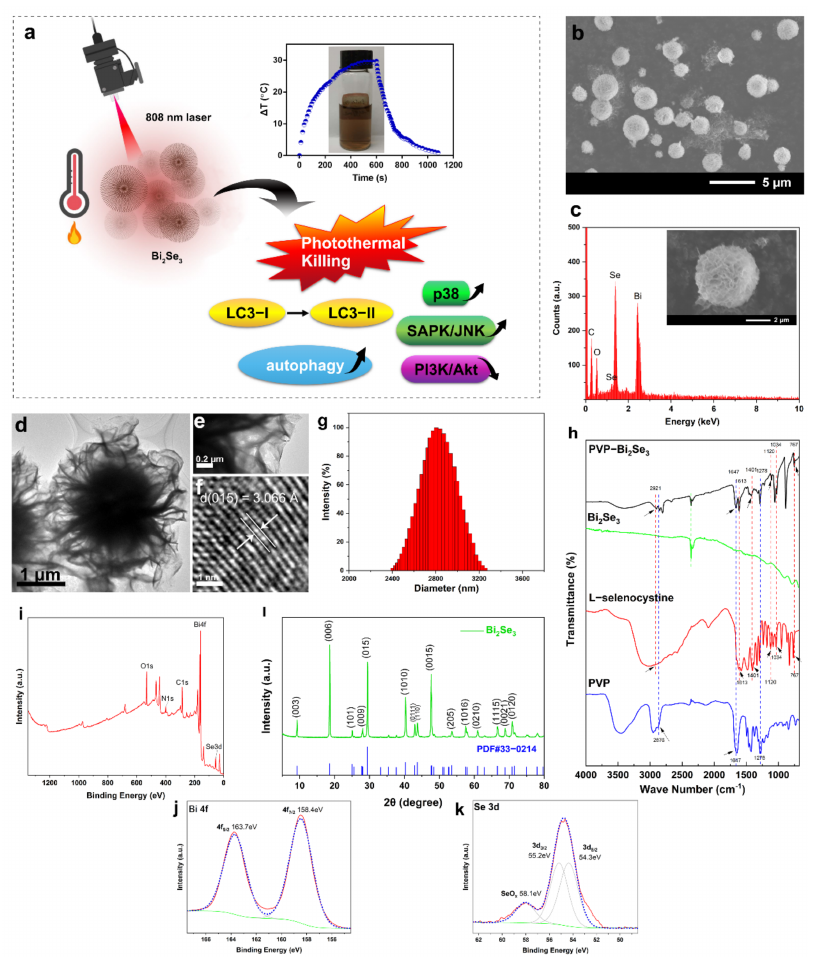
Figure 1. Physicochemical characterizations of Bi 2 Se 3 . ( a ) Scheme shows that the synthesized Bi 2 Se 3 performed a remarkable photothermal killing of A549 cells with autophagy involved; ( b ) SEM image of PVP-Bi 2 Se 3 ; ( c ) EDS spectrum of Bi 2 Se 3 . The insert shows a high-magnification SEM image; ( d ) TEM image of the synthesized Bi 2 Se 3 ; ( e , f ) Magnified TEM image; ( g ) The size distribution of Bi 2 Se 3 dispersed in water; ( h ) FTIR spectra of PVP-Bi 2 Se 3 , Bi 2 Se 3 , L-selenocysteine and PVP; ( i ) Survey scan XPS spectrum of PVP-Bi 2 Se 3 ; HR-XPS spectra of ( j ) Bi 4f and ( k ) Se 3d scans of PVP-Bi 2 Se 3 . The solid lines represent the data curves, while the dotted lines are the fitted curves; ( l ) XRD patterns of PVP-Bi 2 Se 3